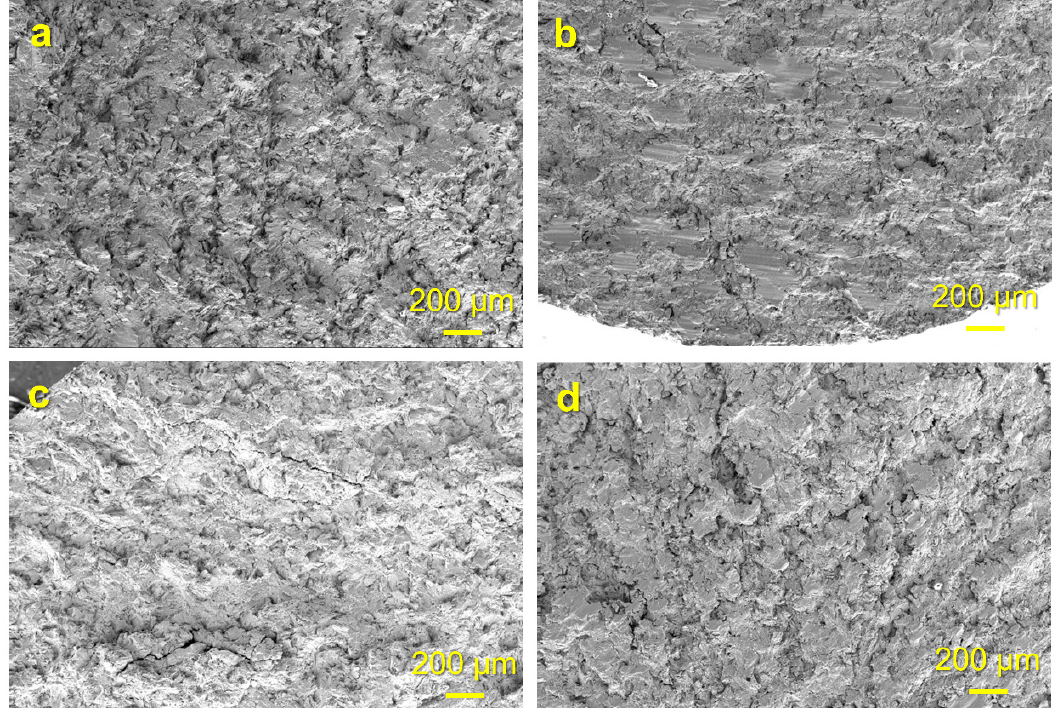
Figure 7. Typical macroscopic morphology of the fracture surface of the TiAl specimen at ( a ) 750 °C, 𝜀 (cid:3028) = 0.44%, ( b ) 400 °C, 𝜀 (cid:3028) = 0.44%, ( c ) 750 °C, 𝜀 (cid:3028) = 0.60% and ( d ) 400 °C, 𝜀 (cid:3028) = 0.60%.